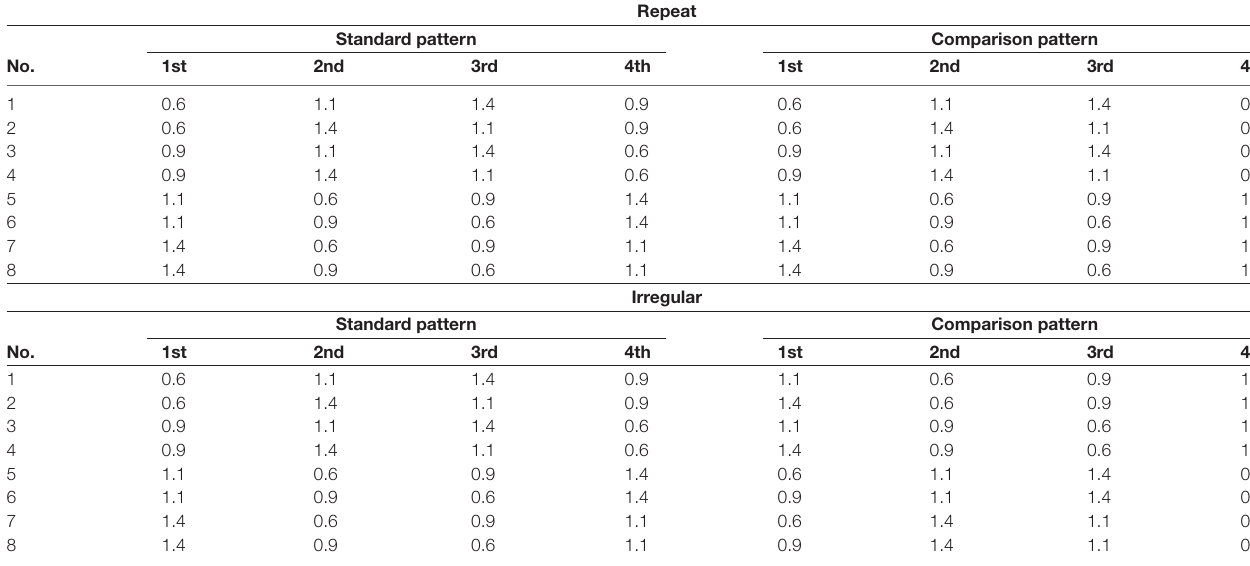
TABLE 1 | Intervals of the standard and comparison patterns for the repeat and irregular